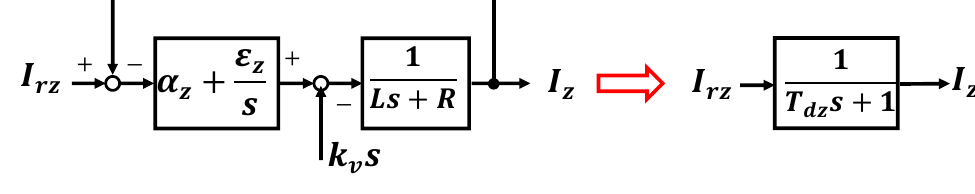
Figure 11. Current Figure 11. Current feedback.